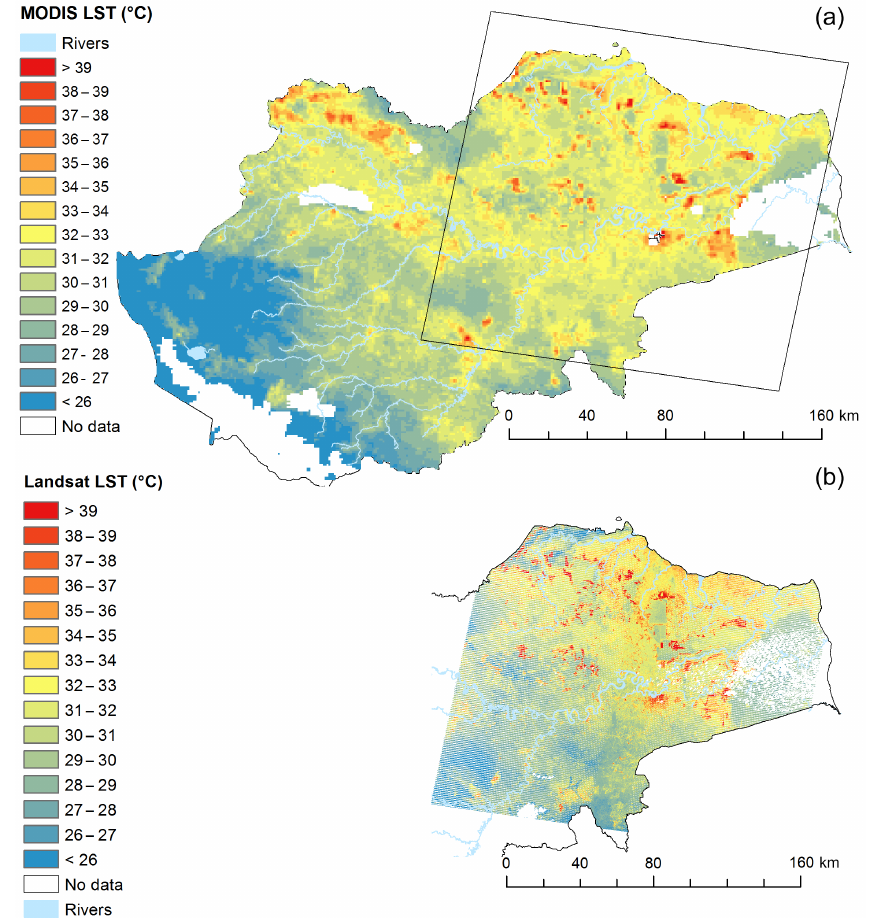
Figure 2. MODIS LST image (a) compared with Landsat LST image (b) . Cloud cover and cloud shadow cover resulted in data gaps (no data). The difference in acquisition time between the images is 15min. The square in the MODIS image is the area that is covered by the Landsat tile (path 125, row 61). Both satellite images were acquired on 19 June